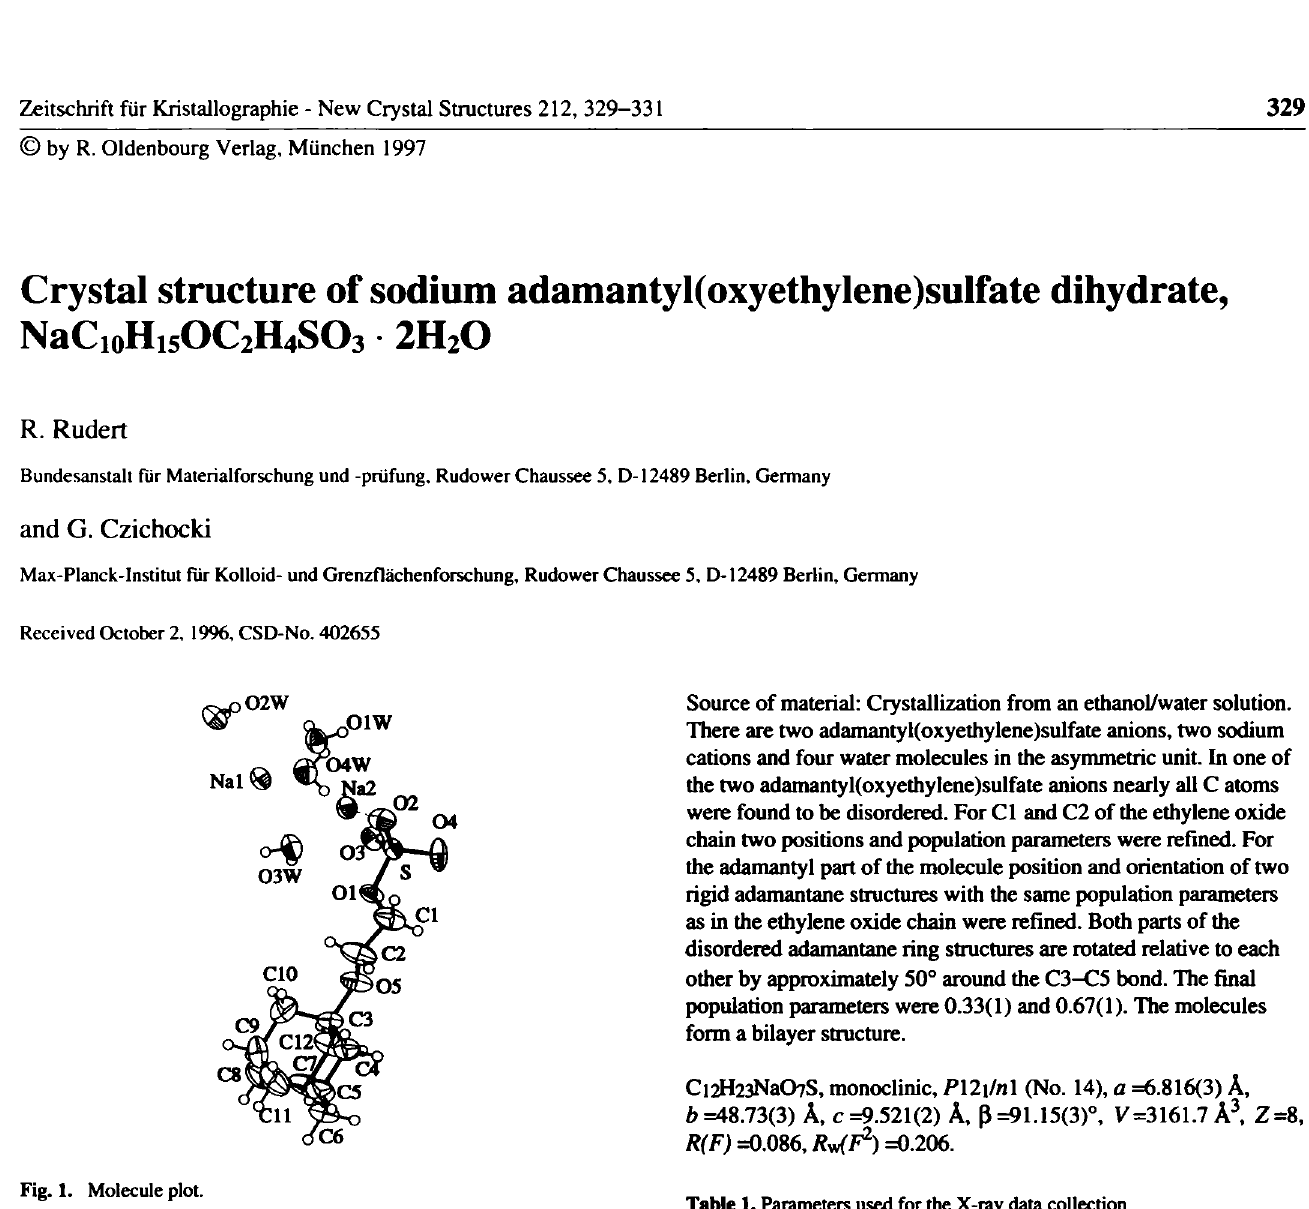
Table 1. Parameters used for the X-ray data collection Crystal: